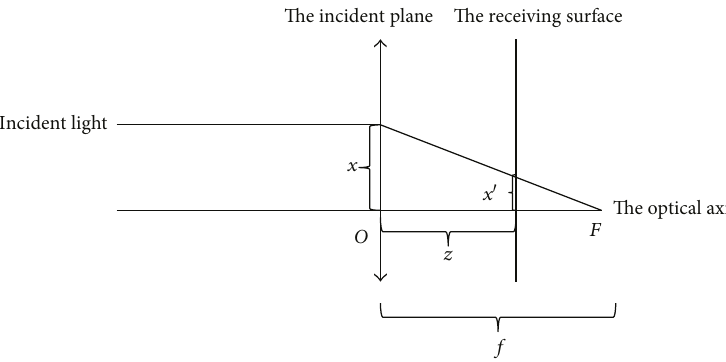
Figure 1: The light path of a normal incidence light passes through a Fresnel